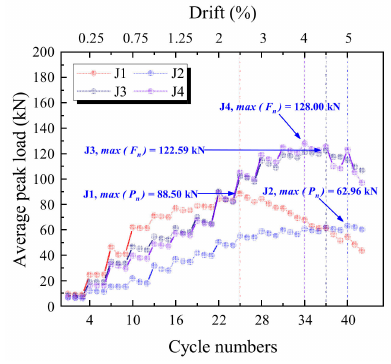
Figure 13. Average peak load.